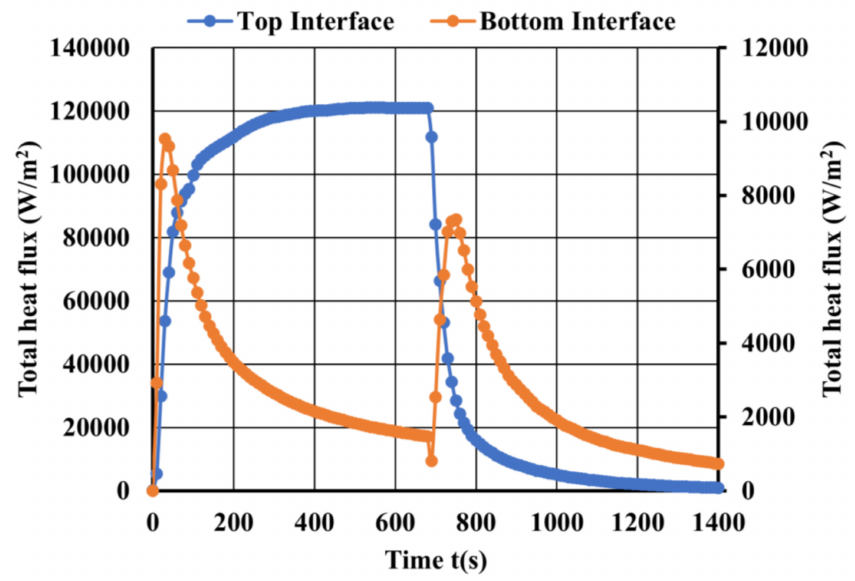
Figure 14. Total heat fluxes at the top and bottom interface (Re = 50).